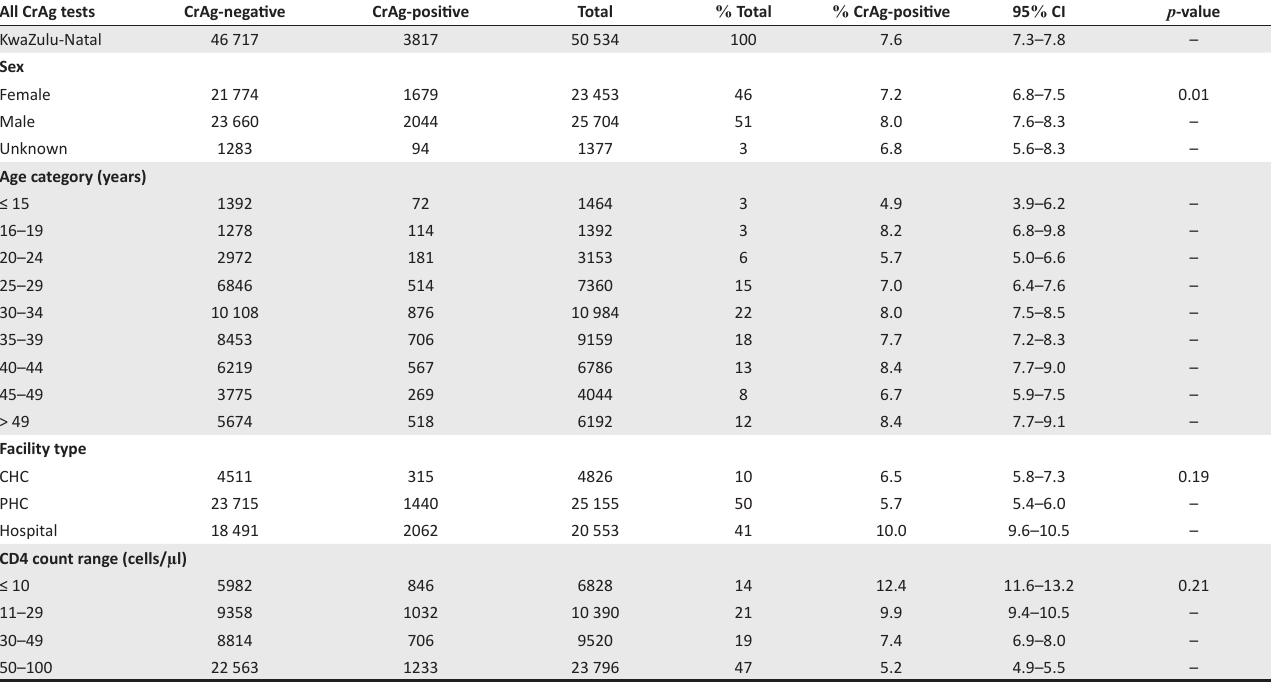
TABLE 1: KwaZulu-Natal provincial CrAg positivity descriptive statistics from October 2016 to June 2017. All CrAg